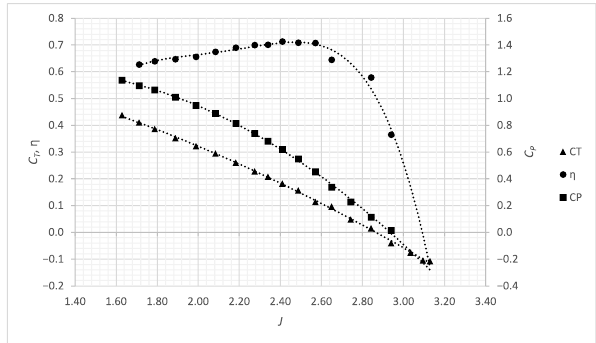
Figure 6. Isolated propeller characteristics from wind tunnel measurements [37].